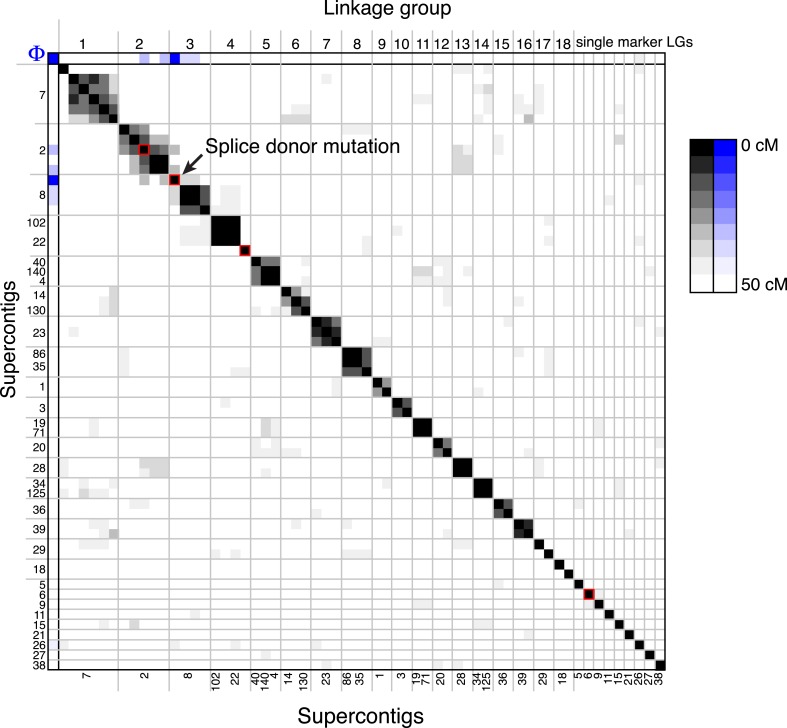
A linkage map for S. rosetta.Linkage map of S. rosetta, based on the genotypes of the 178 independent Rosetteless–Isolate B cross progeny (LOD cutoff = 5). The color of each box represents the genetic distance between two markers (shades of gray; see key) or the genetic distance between a marker and the Rosetteless phenotype (shades of blue; see key), thresholded such that non-significant distances are white (one-tailed Fisher's exact test, p > 0.05). The boxes representing the four SNVs that were unique to Rosetteless are outlined in red. Gray lines show the boundaries between assembled linkage groups, labeled at the top of the figure. The supercontig locations of each marker are listed, in order, on the left and bottom sides of the figure. Note that the Rosetteless phenotype (blue) is tightly linked only to the splice donor mutation and not to any of the other genomic positions or Rosetteless-specific SNVs. Although there was some observed linkage between linkage groups 2 and 3, this may be an artifact of the segregation distortion and so we conservatively assigned these to separate linkage groups. Figure 4—source data 1 lists the exact genomic and linkage group positions for each marker.